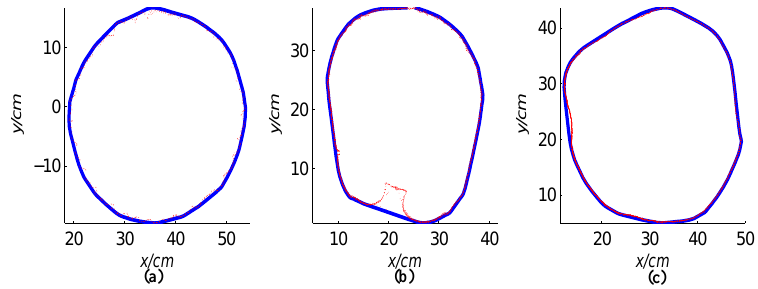
Figure 6. Stem cross-sectional points for the simulation path of the diameter tape. The red points are the original stem points. The blue curve is the closed smooth curve of the simulated path of the diameter tape. ( a ) the simulated path of the stem cross-sectional of Figure 5a; ( b ) the simulated path of the stem cross-sectional of Figure 5c; ( c ) the simulated path of the stem cross-sectional of tree 005 at a height of 1 m.